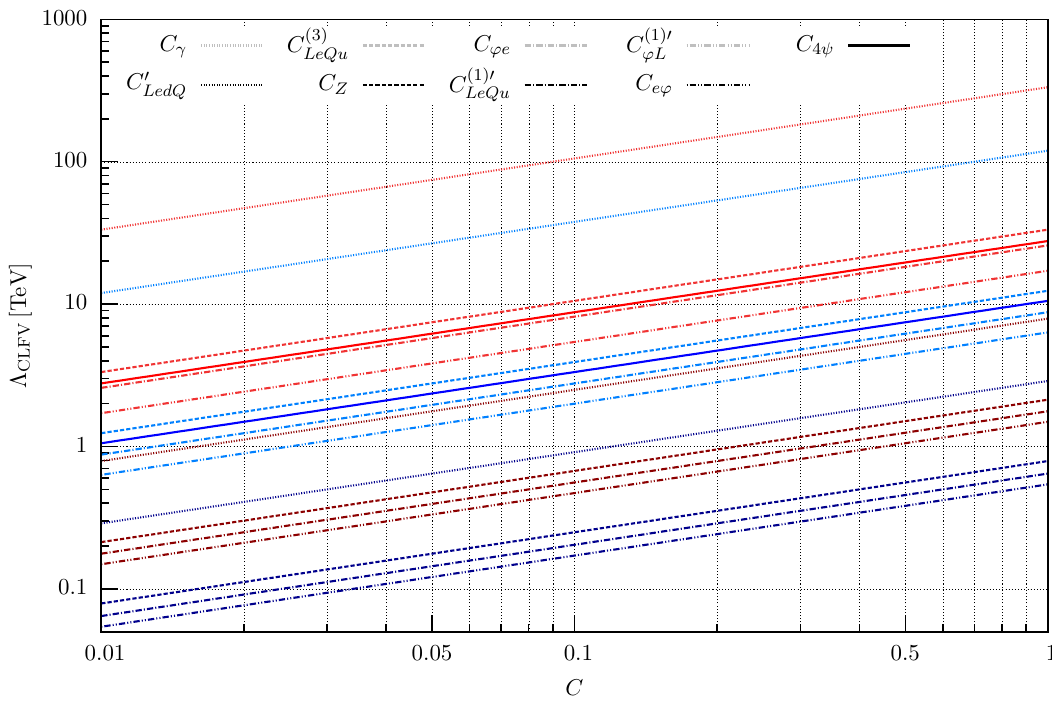
Figure 5 . Constraints on Λ CLFV with respect to the values of WCs, based on the current Belle (shades of blue) and expected Belle II (shades of red) limits, given at the 99.8 % confidence level. The four-fermion WCs are represented altogether as C 4 ψ . For a given set of limits (distinguished by blue and red color shades), the lighter shades correspond to the WCs listed in the first row of the key (omitting now for a moment the common four-fermion WC C 4 ψ ) and the darker shades correspond to the WCs listed in the second row. To make the use of the plot even simpler, for a given set of bounds (red or blue lines), the WCs (again up to C 4 ψ ) are listed in the key in the same order as they appear in the plot, the light-shaded lines being always above the dark-shaded ones. Similarly, for a given WC, the red line appears always above the blue line, corresponding to stronger limits expected from Belle